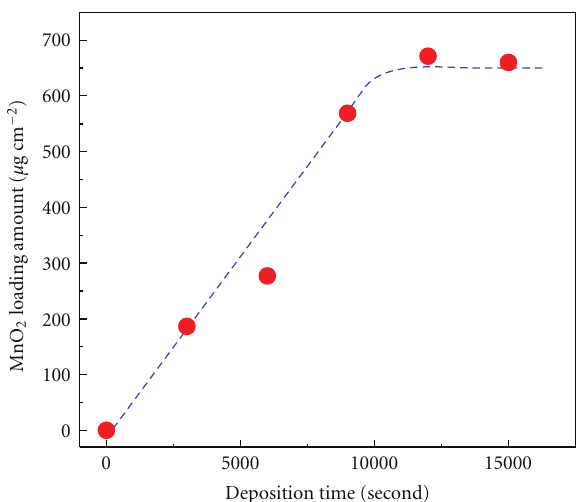
Figure 4: Variation in loading amount of MnO 2 /CNxNTs/CC hybrid electrodes for di ff erent deposition time. (Loading amount measured using